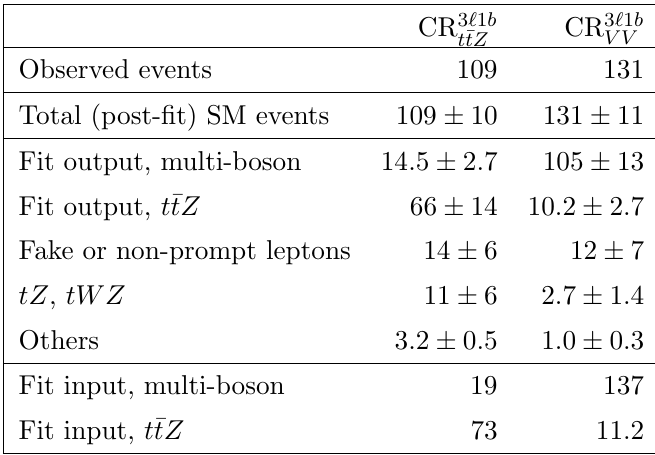
Table 5. Background (cid:12)t results for the control regions in the 3 ‘ 1 b selection. The nominal predic- tions from MC simulation are given for comparison for those backgrounds ( t (cid:22) tZ , multi-boson) that are normalised to data. The \Others" category contains the contributions from t (cid:22) th , t (cid:22) tWW , t (cid:22) tt , t (cid:22) tt (cid:22) t , Wh , and Zh production. Combined statistical and systematic uncertainties are given. The individual uncertainties can be correlated and do not necessarily add in quadrature to the total systematic uncertainty. The number of events with fake or non-prompt leptons is estimated with the data-driven technique described in section